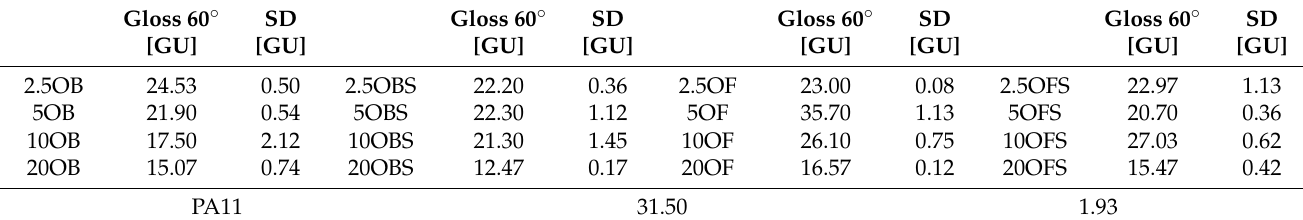
Table 7. Gloss on the composite surface measured at 60 ◦